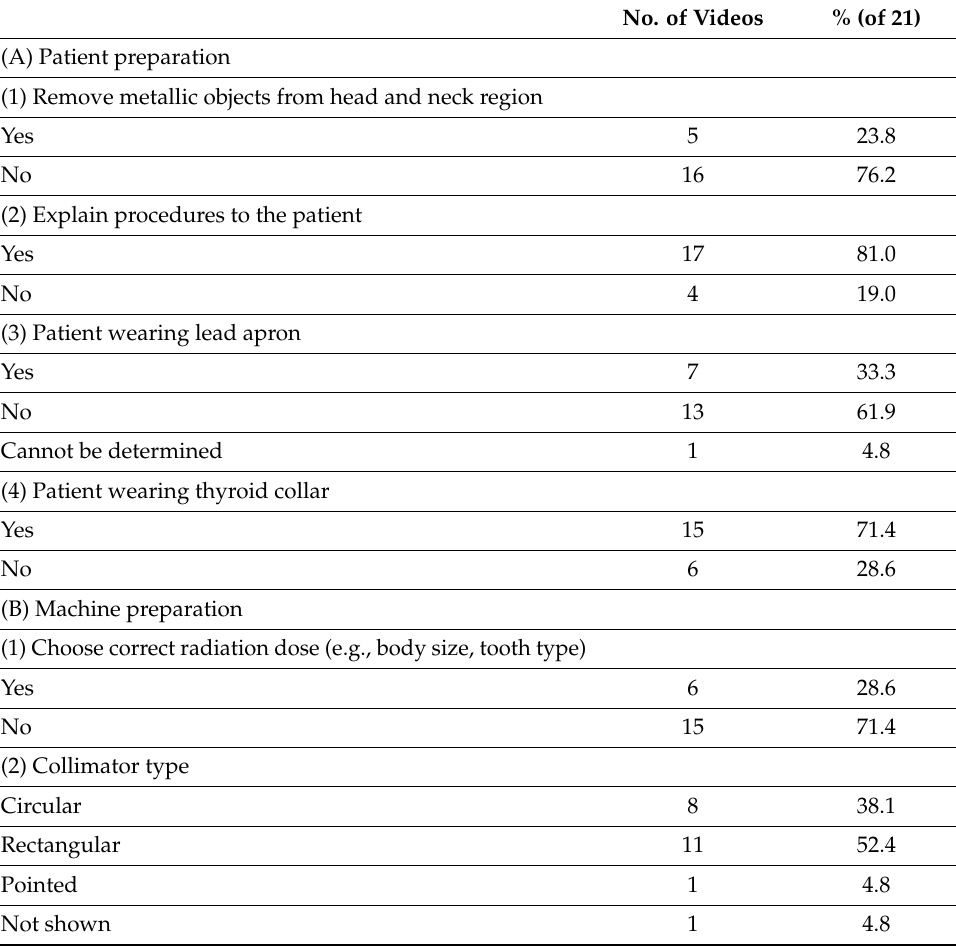
Table 1. The frequency counts of (A) patient preparation, and (B) machine preparation procedures.